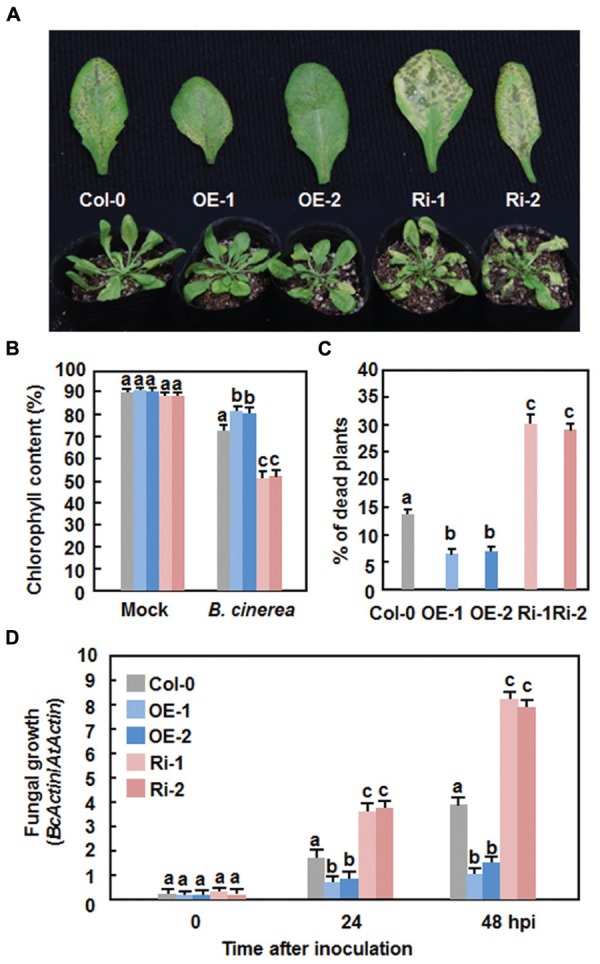
Altered disease responses of AtERF15-OE and AtERF15-Ri plants to B. cinerea. (A) Disease symptom on the AtERF15-OE and AtERF15-RNAi plants. Four-week-old plants were inoculated by foliar spraying with B. cinerea spore suspension (2 × 105 spores/ml) and photos were taken at 5 dpi. (B) Chlorophyll contents in leaves of Col-0, AtERF15-OE and AtERF15-Ri plants after B. cinerea infection. Chlorophyll was extracted from entire rosette leaves of six mock-inoculated and six B. cinerea-inoculated plants for each line and chlorophyll content is shown as percentages of that in the corresponding mock-inoculated plants. (C) Percentages of died plants of Col-0, AtERF15-OE and AtERF15-Ri lines after B. cinerea infection. Each experiment contained at least two plants per line and plants were scored as died when they were completely rotten. (D)
In planta growth of B. cinerea in the Col-0, AtERF15-OE and AtERF15-Ri plants. Measurement of fungal growth was carried out by simultaneous quantification of the transcript levels of B. cinerea BcActinA gene and an Arabidopsis AtActin gene and relative fungal growth was shown as ratios of the transcript levels of BcActinA/AtActin. Data presented are the means ±SD from three independent experiments and different letters above the columns indicate significant differences at p < 0.05 level between the AtERF15-OE or AtERF15-Ri and Col-0 plants.